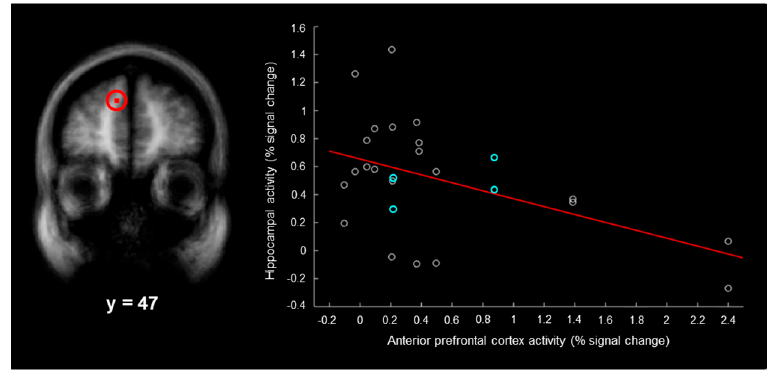
Figure 3. Relationship between the magnitude of spatial memory activity in the left anterior prefrontal cortex and the hippocampus. Left , left anterior prefrontal cortex activity associated with left-hits and left-misses (circled in red; coronal view). Right , for each participant, the magnitude of hippocampal activity associated with false memories as a function of the magnitude of left anterior prefrontal cortex activity associated with false memories (the best-fit line is shown in red; results from male participants are shown in blue).